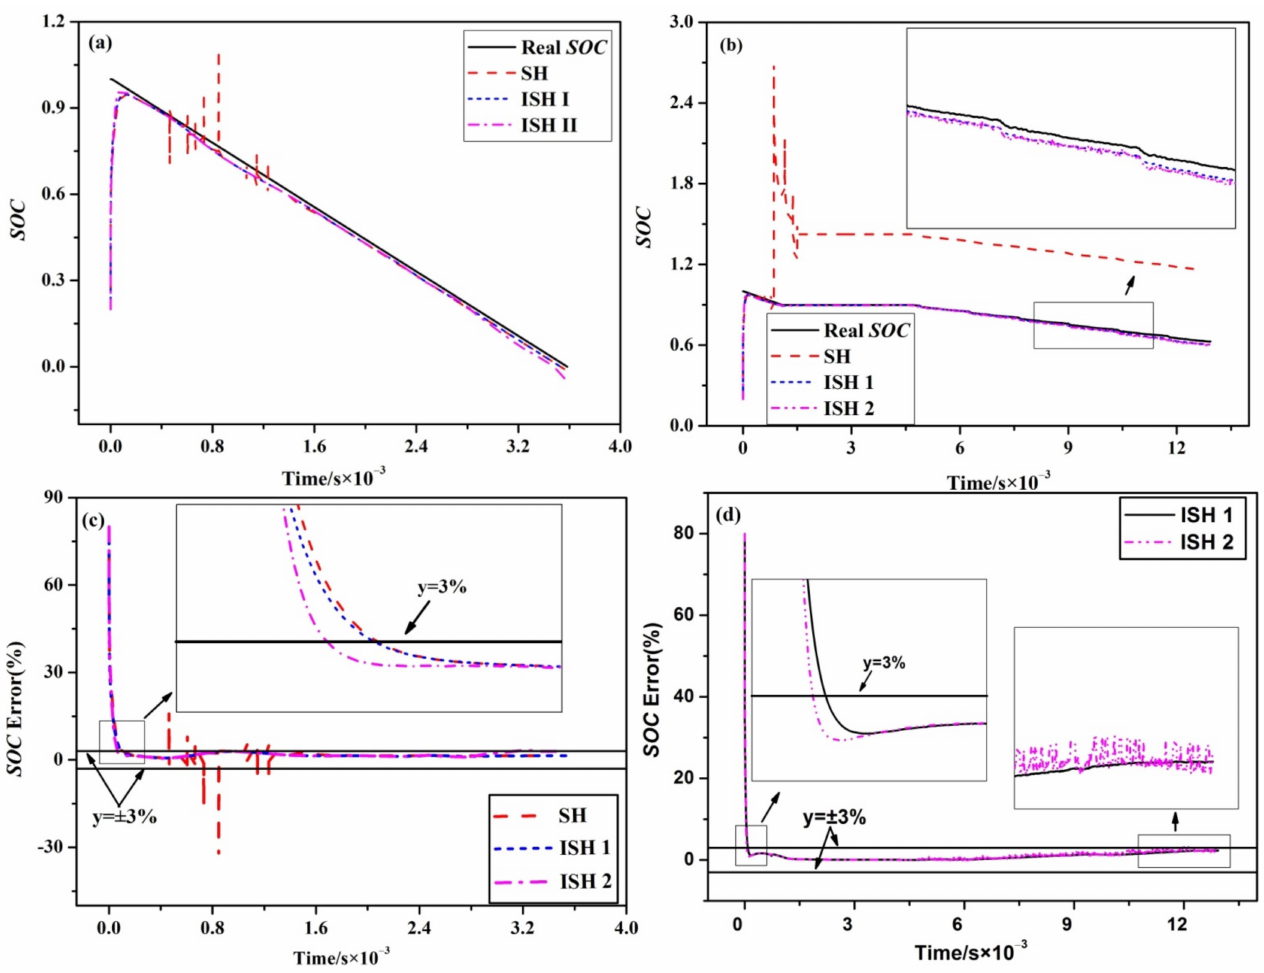
Figure 3. The SOC estimation results and errors based on the SH algorithm: ( a ) the result of SOC estimation under the CCD test, ( b ) the result of SOC estimation under the FUDS test, ( c ) the SOC error under the CCD test, ( d ) the SOC error under the FUDS